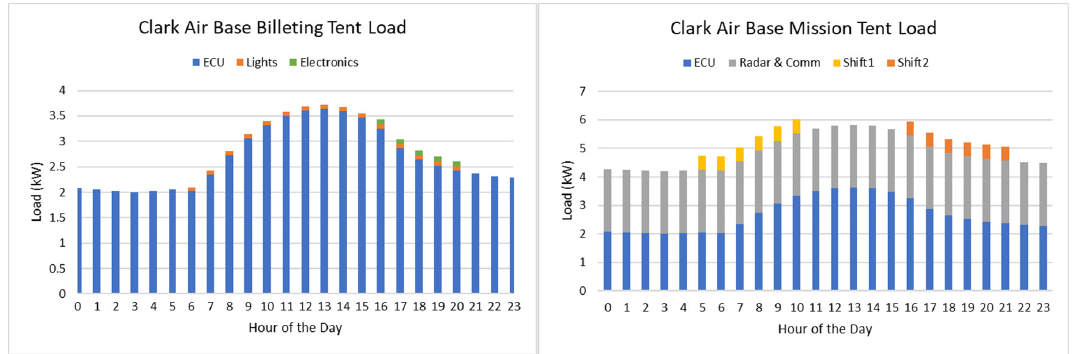
Figure 5. Individual billeting ( left ) and mission tent ( right ) power loads. On the right chart, Shift 1 and Shift 2 show the estimated power loads due to mission-essential functions. ECU: environmental control unit.